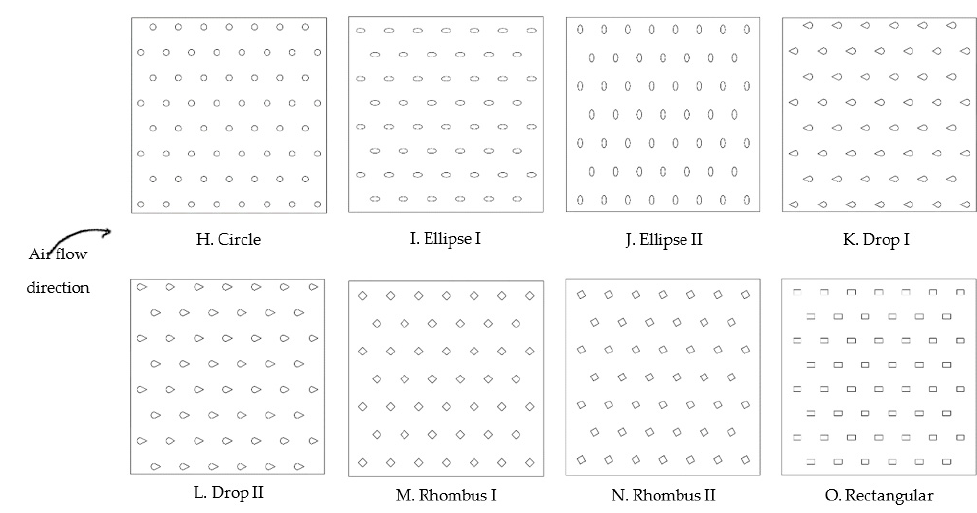
Figure 5. Different pins shapes under study.